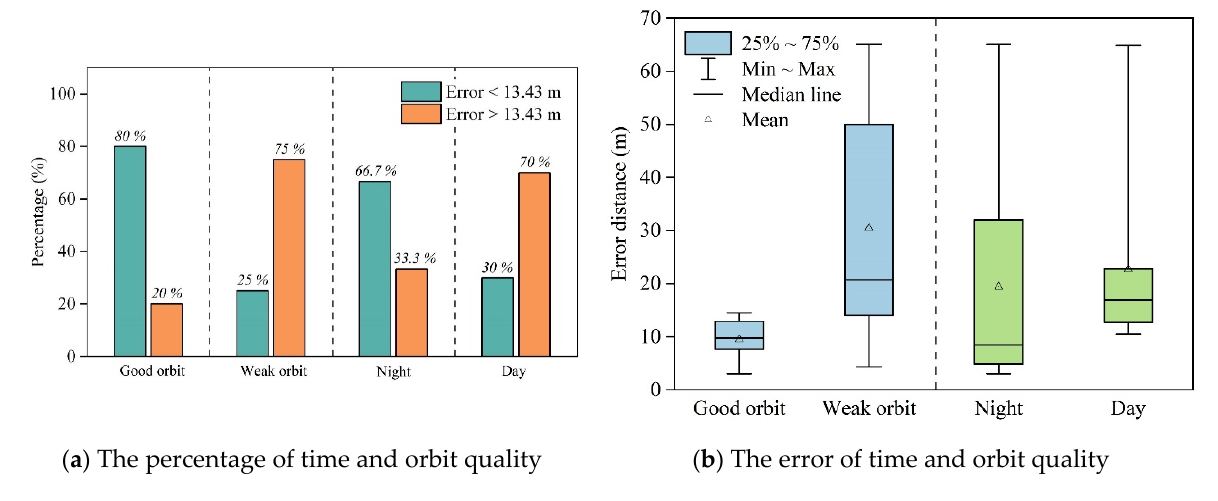
Figure 4. The analysis of GEDI geolocation error is based on acquisition time (night/day) and orbit quality (good/weak). ( a ) The percentage of nighttime/daytime and good/weak orbit types of temporal GEDI footprints in two error groups; ( b ) the geolocation error distance distribution of four different conditions (including time and orbit quality).